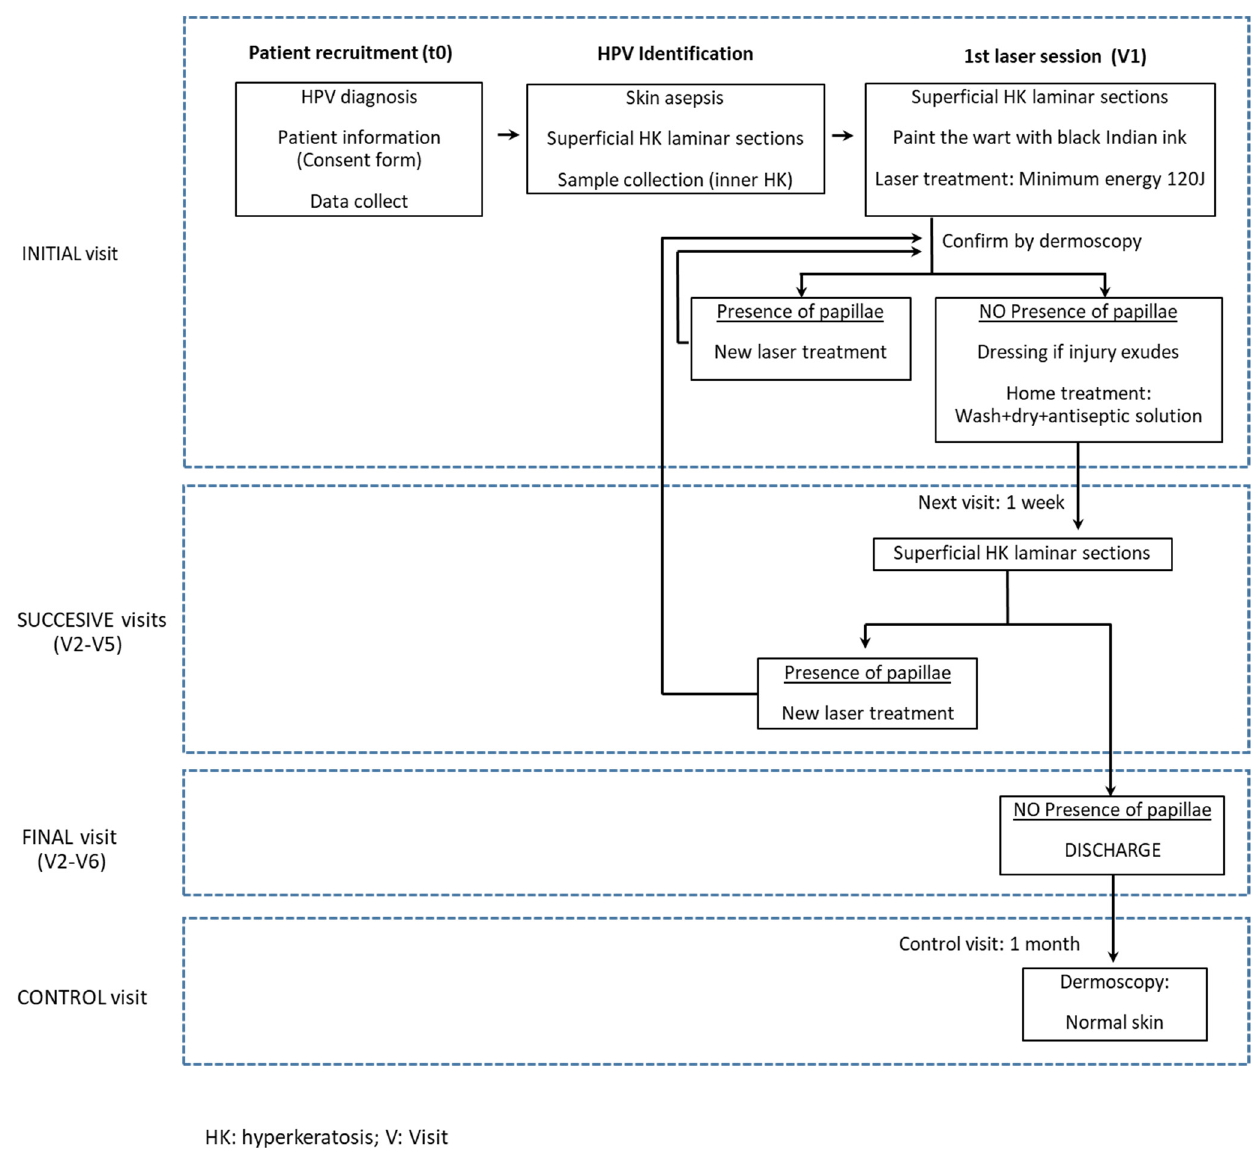
Figure 1. Flux diagram for the diagnosis and laser treatment of plantar warts.